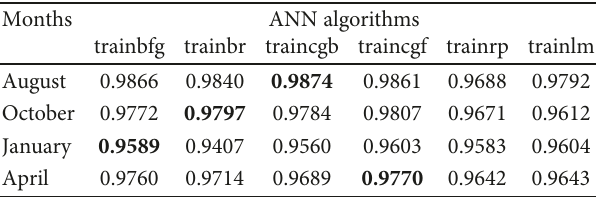
Table 5: ANN algorithm estimation results in Malatya. Months ANN